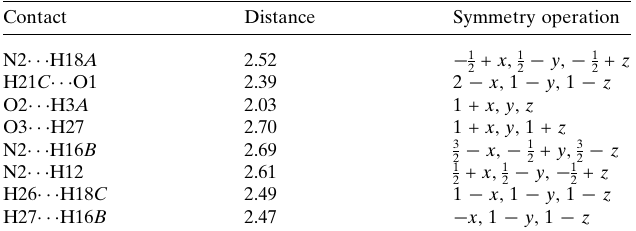
Table 2 Summary of short intermolecular contacts (A˚ ) in the title structure. Contact Distance Symmetry